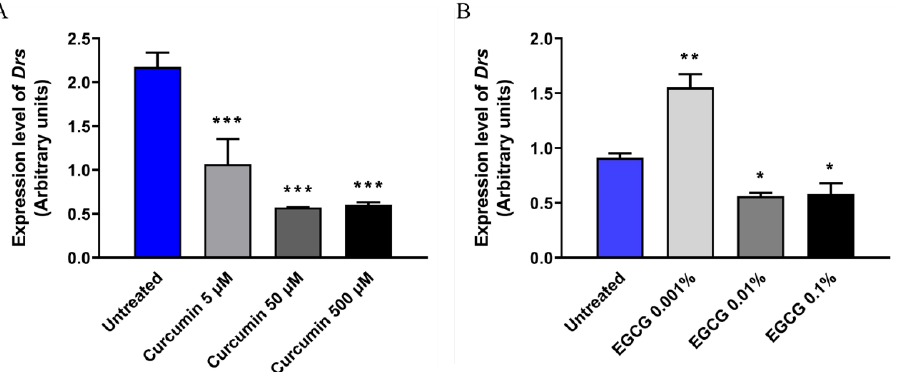
Figure 4. Expression of Drs in adult males of Oregon R in the presence or absence of curcumin ( A ) or EGCG ( B ). For each experiment, adult males of Oregon R at 4 – 7 days old were maintained at 25 °C in fly food containing the respective drug/active compounds. These flies were subjected to total RNA isolation and subsequently followed by RT-qPCR for quantification of Drs mRNA level. The expression level of rp49 was used as the reference control. EGCG, epigallocatechin gallate; * p < 0.05, ** p < 0.01, *** p < 0.001.